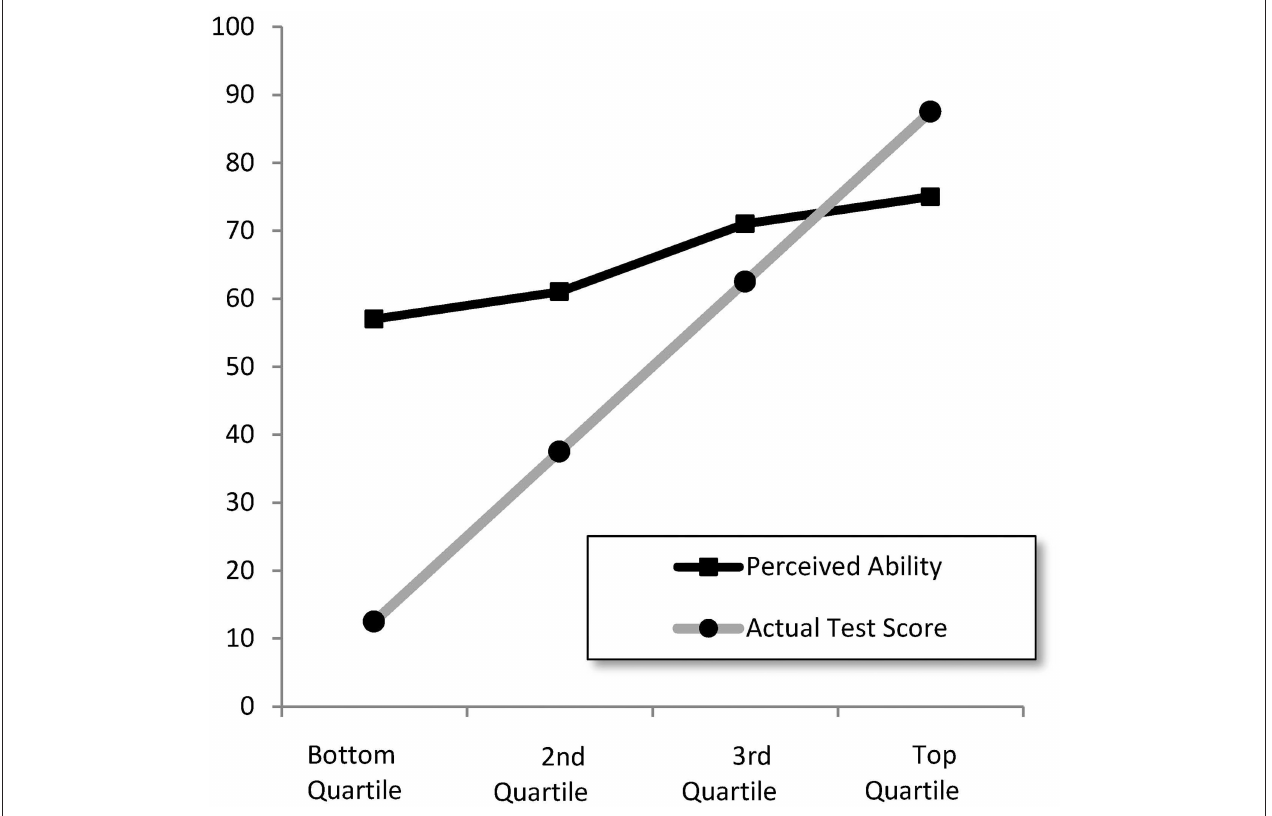
FIGURE 1 | Perceived ability to recognize humor as a function of actual test performance (from Kruger and Dunning,